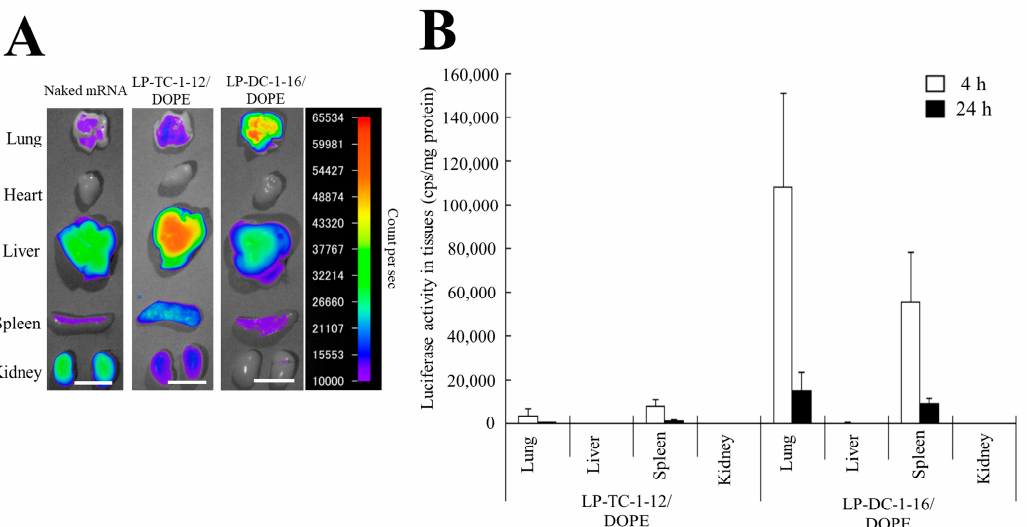
Figure 9. mRNA biodistribution and protein expression in mice after IV injection of mRNA lipoplexes. ( A ) mRNA lipoplexes with 10 µg of Cy5-mRNA were intravenously injected into mice. The mice were sacri fi ced 1 h after injection, and Cy5 fl uorescence images of the tissues were acquired with an exposure time of 5 s. Scale bar = 1 cm. ( B ) mRNA lipoplexes with 20 µg of FLuc mRNA (5moU) were administered systemically into mice. The mice were sacri fi ced 4 or 24 h after injection, and the luciferase activity of the tissues was measured. Each column represents the mean + S.D. ( n = 4–5).